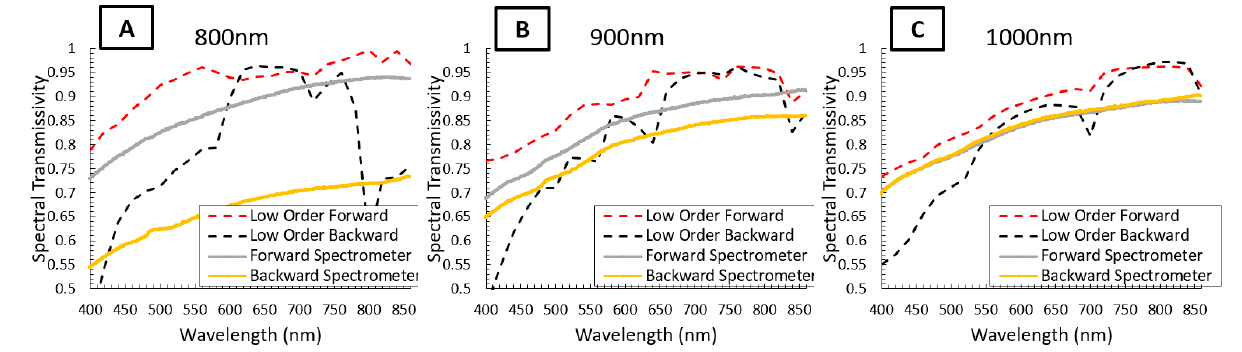
Figure 6. Prediction for transmissivity of low diffraction orders (m = ( − 2, − 1, 0, 1, 2)) in the forward direction and backward direction plotted against the data collected by the spectrophotometer for periodicities: ( A ) 800 nm, ( B ) 900 nm, and ( C ) 1000 nm.